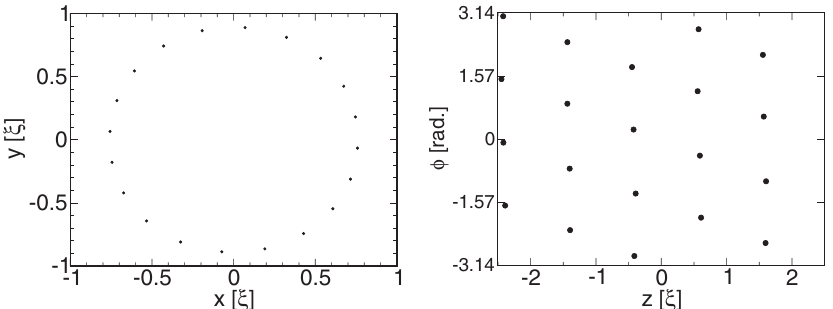
FIG. 3. Projections in the x - y (left) and z - (cid:8) (right) planes of an one-shell, three-dimensional crystalline beam with (cid:2) (cid:2) 4 : 0 and 20 particles per unit cell, where (cid:8) (cid:6) tan (cid:1) 1 (cid:3) y=x (cid:5) is the polar angle. The horizontal and vertical tunes are (cid:2) respectively. The beam’s Lorentz relativistic factor is (cid:1) (cid:2) 1 : 000 016 .